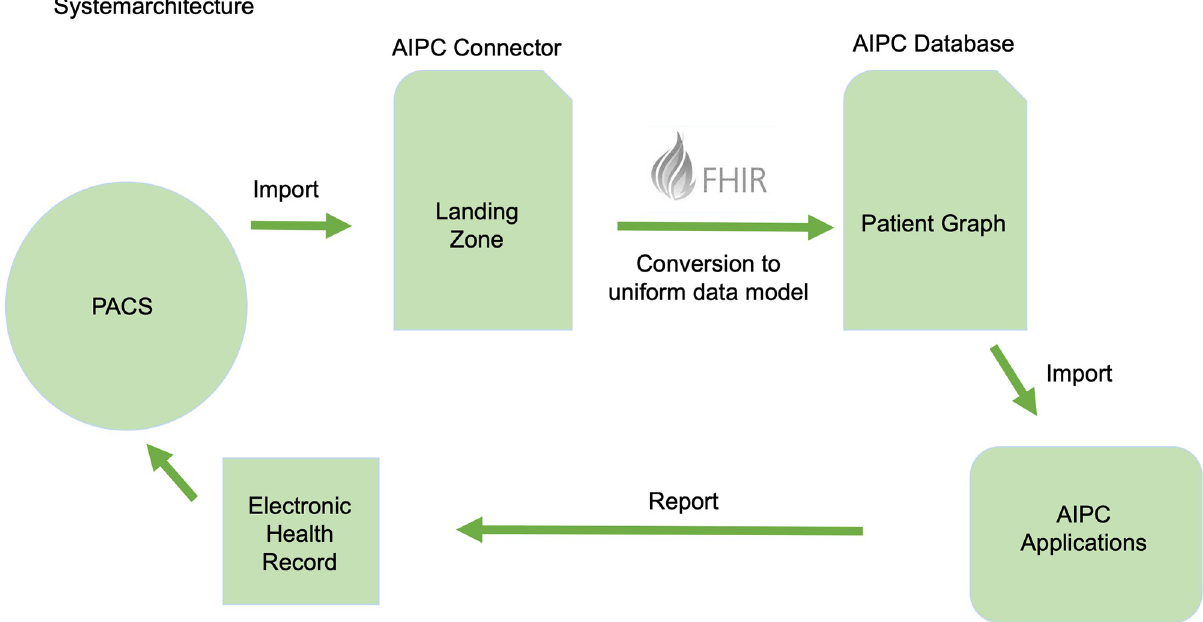
Fig 2. The web-based AIPC product suite consists of several components (AIPC Connector, database and applications). The AIPC Connector is responsible for importing data from various data sources. Imported data (e.g. CSV files, SQL databases, EHR and PACS) are imported from the primary data sources and temporary stored in the Landing Zone. In the Landing Zone data are converted to a uniform data model (FHIR). The AIPC Database can import converted data through an FHIR interface. The data is then made visible to the end user on the AIPC applications in form of Dashboards, MDT reports, radiology images, etc. After decisions for a diagnostic or therapeutic measure have been made, a report can be generated within the AIPC applications for documentation purposes, which can then be sent back to the source system via a shared network file system (electronic health record (EHR).